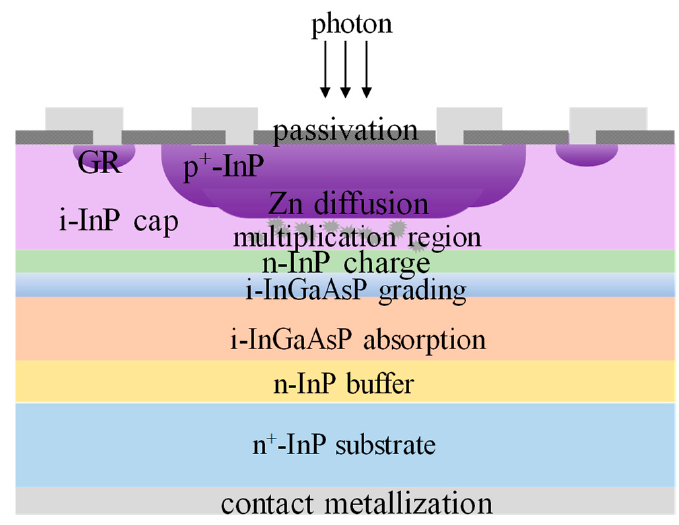
Figure 44. Schematic diagram of front illuminated InGaAs/InP SAGCM SPADs.